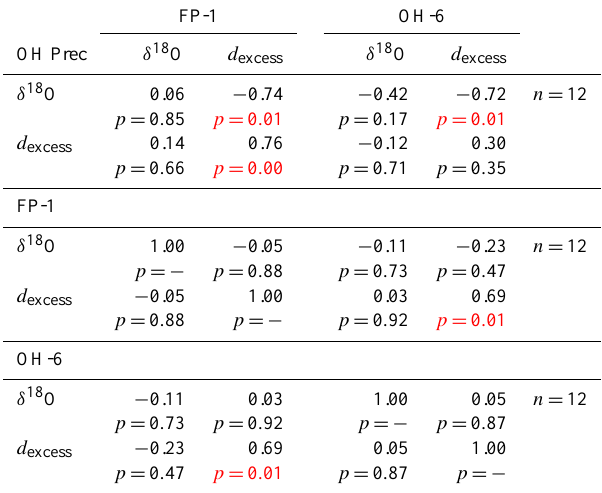
Table 5. Correlation matrix of monthly isotope means of firn core FP-1 and OH-6 (resample values) and precipitation from OH station for the 12 months common period (March 2008 to March 2009). Significant p-level ( p < 0 . 05) are marked in red for easy recogni-